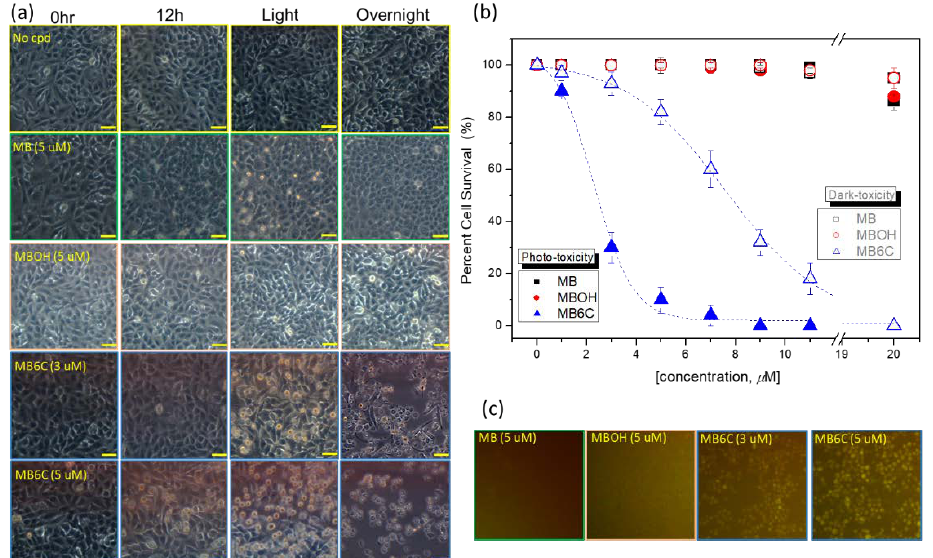
Figure 6. ( a ) Several extracted bright-field photodamage photographs from A549 lung cancer cells incubated with or without phenothiazine derivatives, 5 µM MB, MBOH, and MB6C and 3 µM of MB6C, for 12 h in order to check the dark toxicity. Then cells were irradiated with an average 18 J·cm − 2 of light source (510 nm lp) for 20 min and cell deaths were estimated after a further 12 h. ( b ) Dark toxicity and phototoxicity cell viability plots of A549 cells treated with variable concentrations of phenothiazine derivatives, as in the experiment in ( a ). Each datapoint is the average from three separate experiments. ( c ) Fluorescent photodamage images extracted from experiment ( a ) to check the cellular uptake for every compound in ( a ).